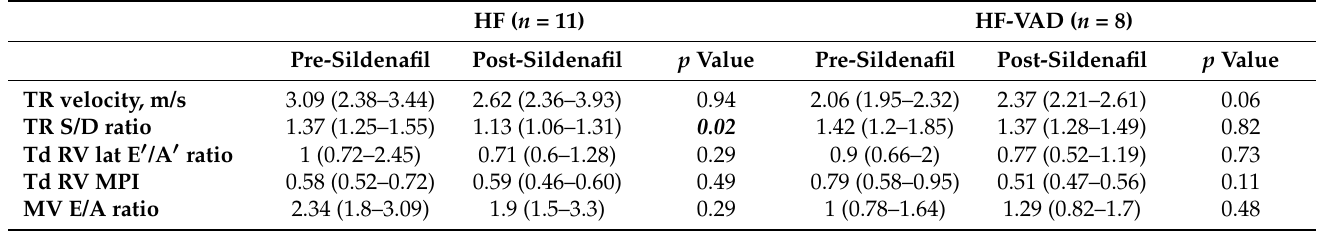
Table 3 details relevant doppler data including TR doppler measures as well as assess- ment of tissue doppler. The median TR velocity was 3.09 m/s and 2.06 m/s in the HF and HF-VAD groups respectively. In the HF group, TR S/D ratio showed statistically significant decrease in paired analysis after therapeutic use of sildenafil. Other doppler parameters across both the HF group and the HF-LVAD group showed overall no measurable pattern of change. Table 3. Doppler echo parameters in the HF and HF-VAD groups before and after sildenafil therapy. The values are expressed as medians (interquartile ranges) unless otherwise